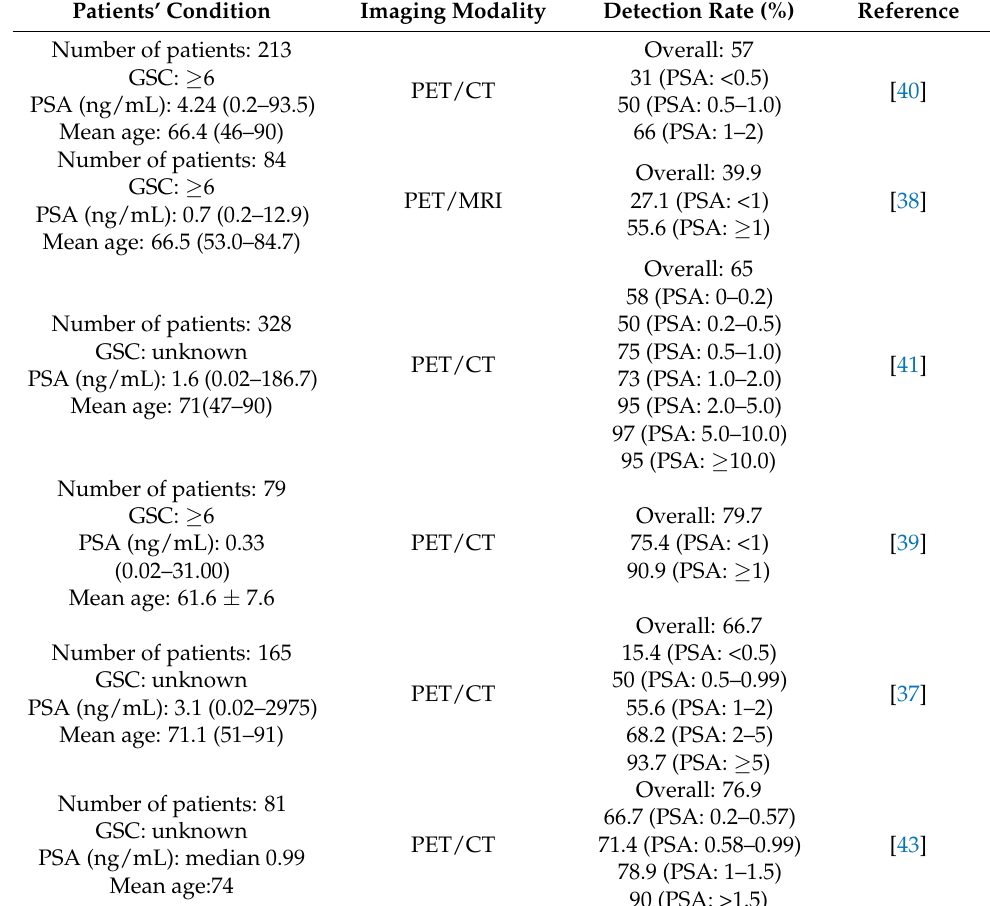
Table 2. Diagnostic performance of [ 18 F]FACBC in the BCR of